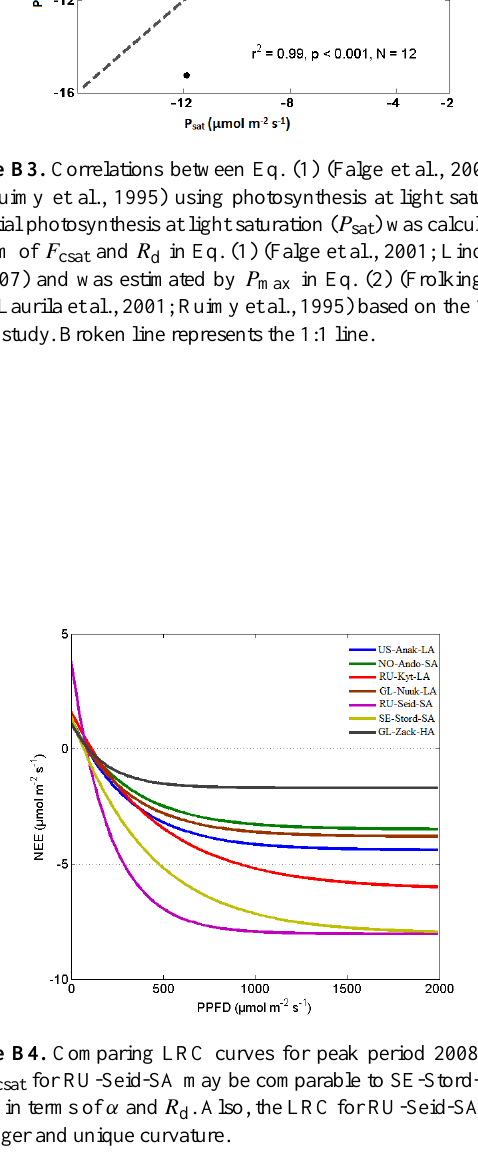
Figure B2. Comparing Eqs. (1) and (2) using Seida 2008 peak sea- son. The LRC curves suggest that the parameters R d and α from Eq. (1) are comparable with R and α 2 from Eq. (2).